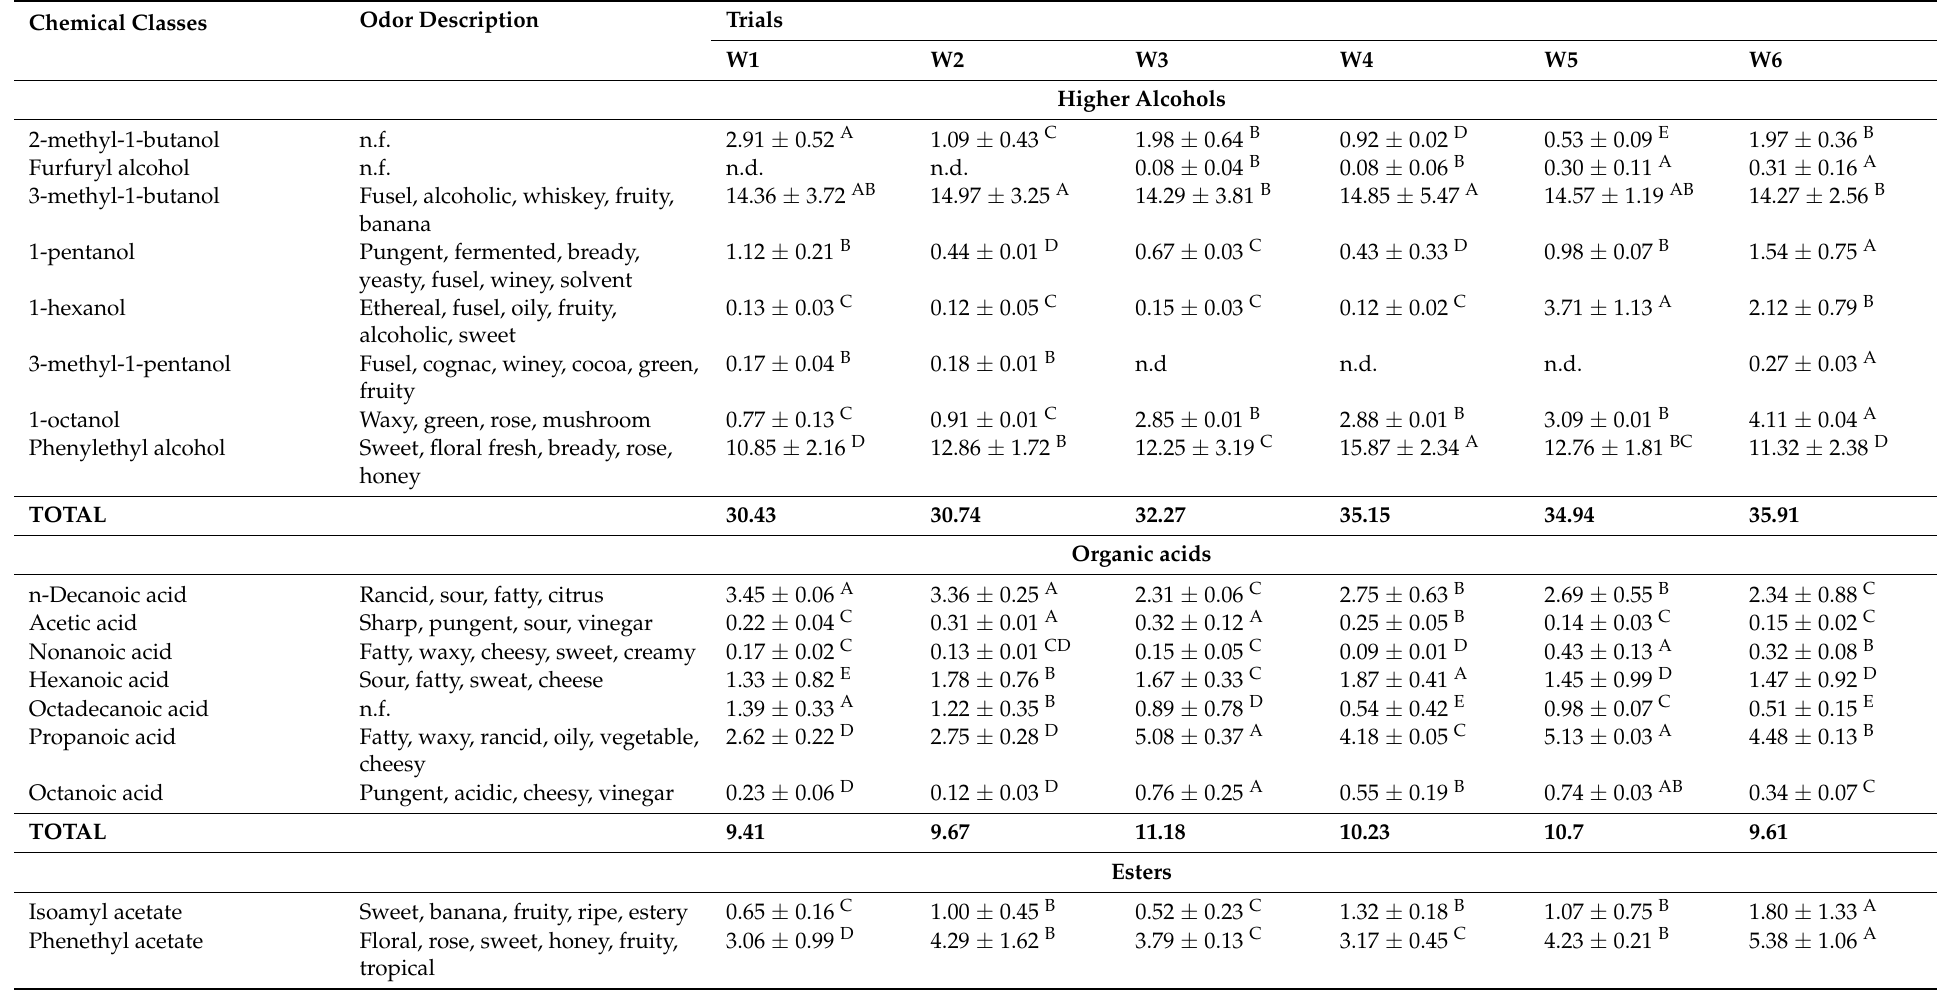
Table 4. Aroma compounds detected and their olfactory description. Data are expressed as